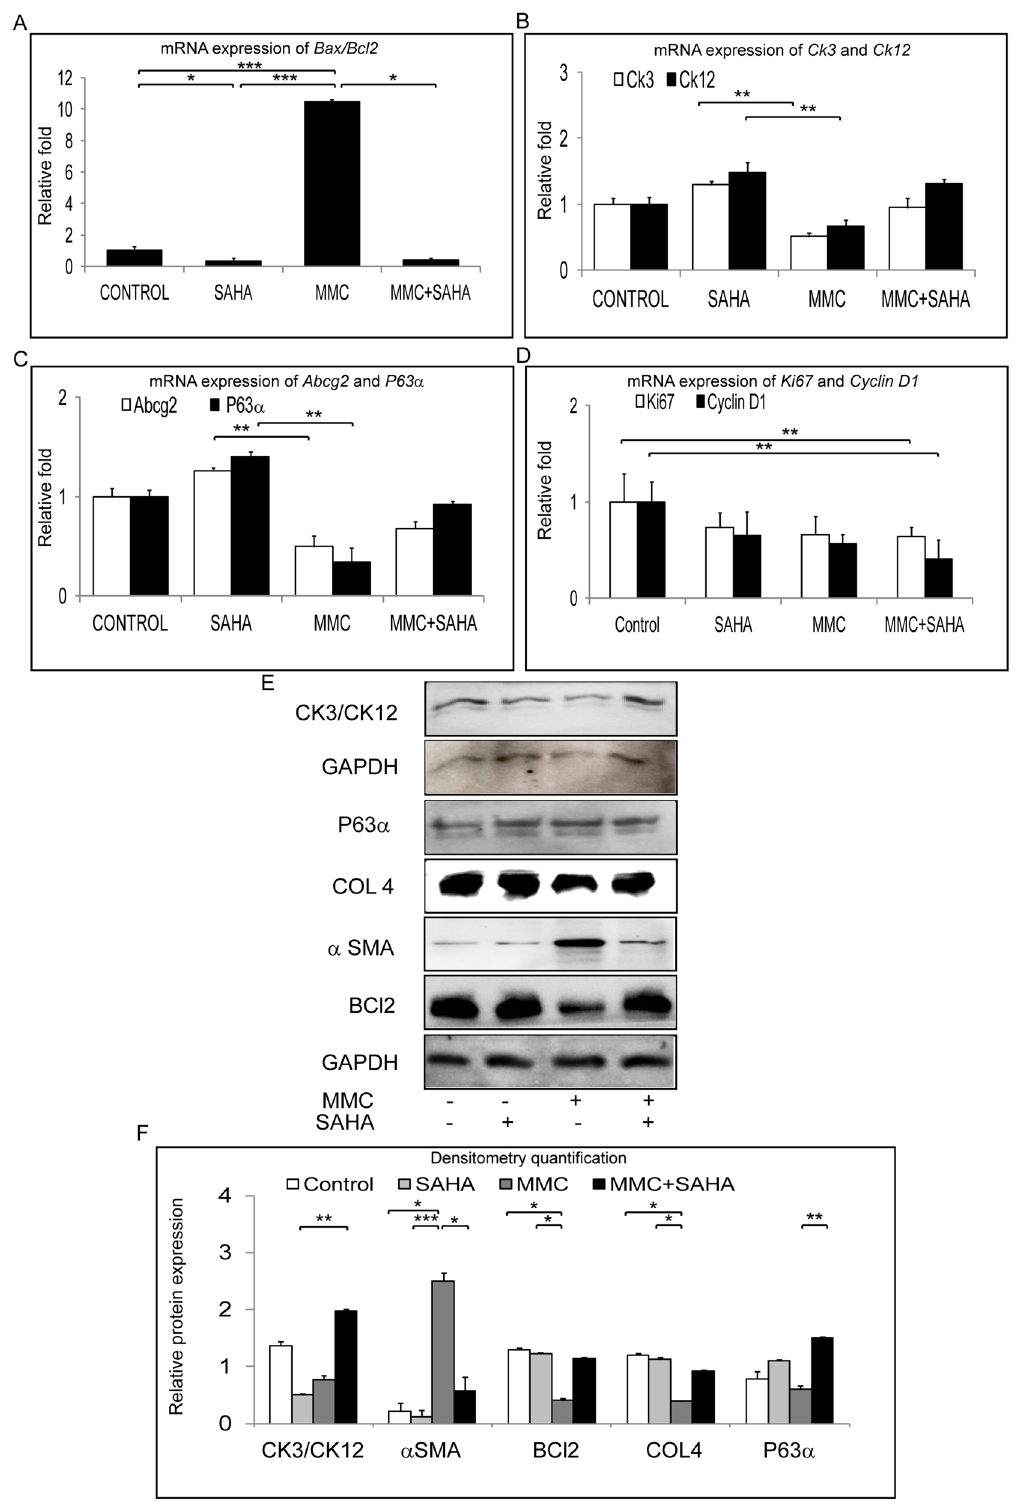
Figure 7. Long term effect of MMC and SAHA on limbal stem/progenitor cells. Ratio of relative mRNA expression of Bax and Bcl2 was estimated in cells obtained from study group 3 ( A ) (n = 4). Relative mRNA expression of Ck3, Ck12 ( B ), Abcg2, ∆NP63 ( C ) and Ki67, Cyclin D1 ( D ) in cells obtained from study group 3 (n = 4). Western blot results showing the expression of CK3/CK12, ∆NP63, COLL4, αSMA, BCl2 and GAPDH in cells obtained from study group 3 ( E ). Graphical representation of relative protein expression quantification of Western blots (n = 3) (F). Statistical significance based on one way ANOVA test denoted by *p ≤ 0.05, **p ≤ 0.01, ***p ≤ 0.001 was calculated. Western blots images were quantified using Image J 1.48 version software (http:// image j.nih.gov/ij/) and statistical analysis performed using statistical software GraphPad PRISM Ver